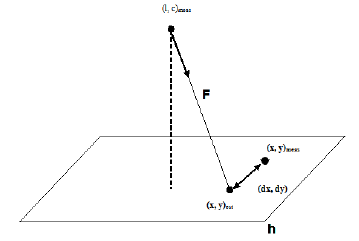
Figure 3. Illustration of the method for estimating location performance in